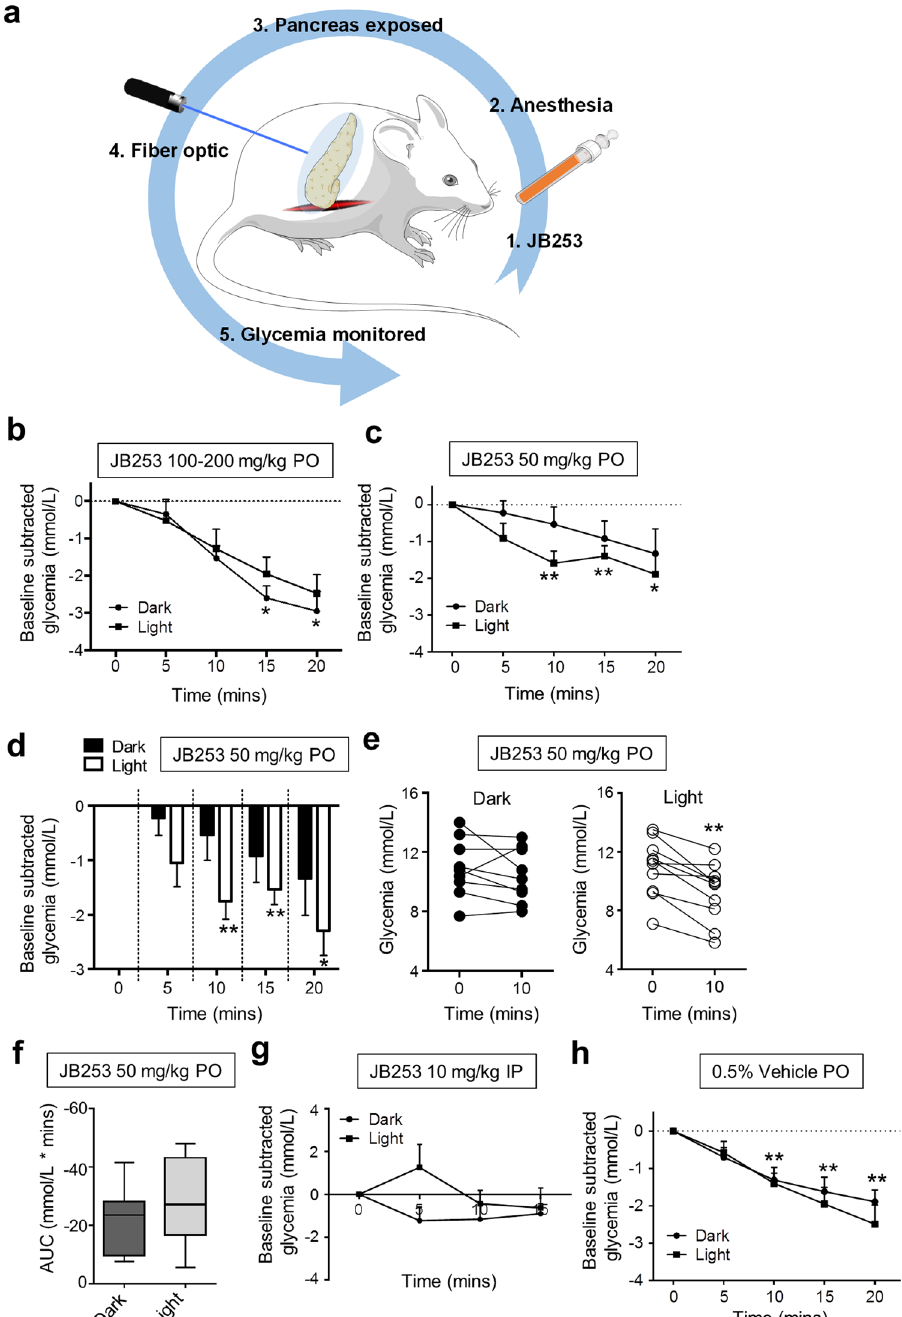
Figure 4. Optical control of glucose homeostasis using JB253. ( a ) Schematic showing the experimental protocol for in vivo photopharmacology in mice (adapted from Servier Medical Art under a CC-BY licence) (https:// creativecommons.org/licenses/by/3.0/). ( b ) JB253 100–200 mg/kg administered per os (PO) significantly decreases glycemia in the dark without evidence of photocontrol following illumination with a λ = 470 ± 5 nm (blue) laser ( n = 4 animals per state). ( c ) JB253 50 mg/kg administered PO significantly lowers glycemia only during exposure to blue light ( λ = 470 nm) ( n = 9–10 animals per state). ( d ) As for ( c ), but bar graph to better show the differences between light/dark. ( e ) Before-and-after plot showing that all animals receiving JB253 50 mg/kg responded to light with decreases in glucose concentration ( n = 9–10 animals per state). ( f ) Box and whisker plot showing area-under-the-curve (AUC) in JB253-treated animals under dark or light conditions. ( g ) Light does not significantly influence glycemia in mice injected intraperitoneally with 10 mg/kg JB253 ( n = 3 animals per state). ( h ) As for ( c ), but showing lack of photocontrol in mice receiving vehicle-alone (0.5% CMC) PO ( n = 9–10 animals per state). For multiple comparisons, * P < 0.05, ** P < 0.01; repeated measures one-way ANOVA (Bonferroni’s posthoc test). For pairwise comparisons ( e and f ), ** P < 0.01; paired Student’s t -test or Mann-Whitney U test. Data represent the mean + SEM (or median + range for Box and Whiskers